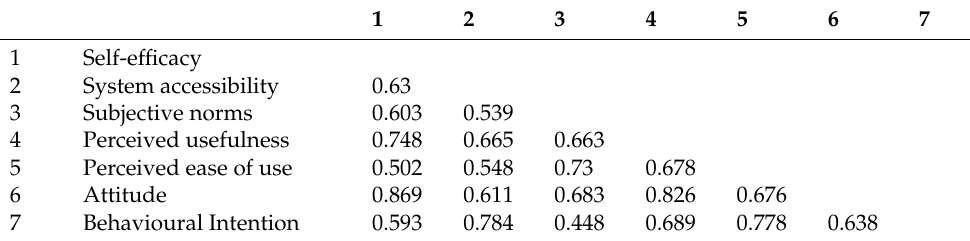
Table 3. Discriminant Validity (HTMT 0.90 ).